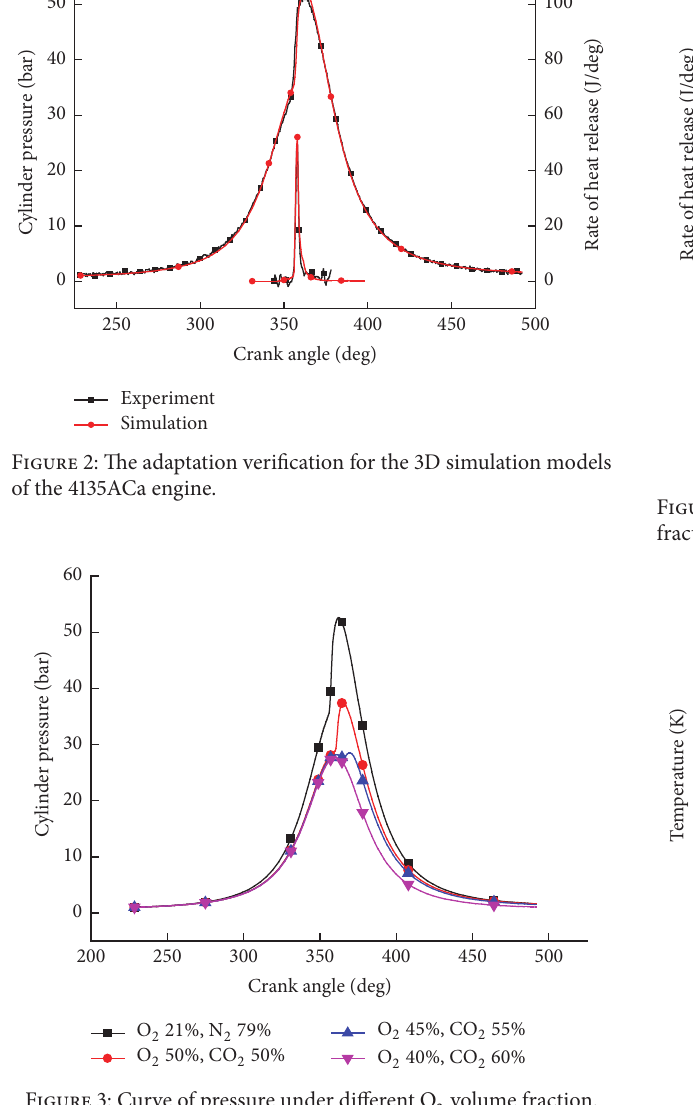
Figure 5: Curve of temperature under different O 2 volume